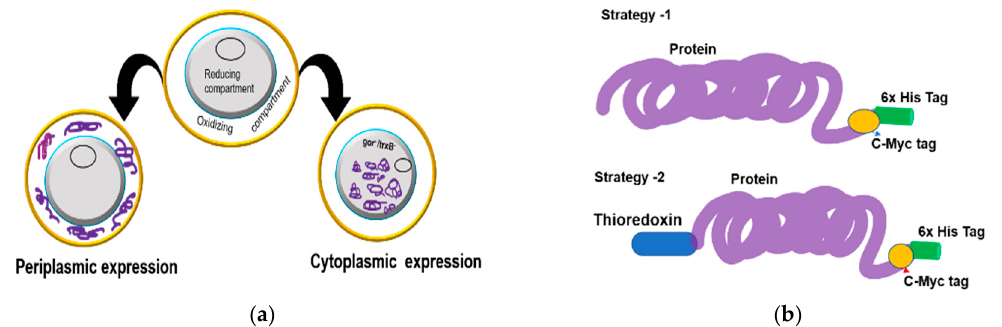
Figure 3. Schematic presentation of the antibody expression in the microbial system. ( a ) Depiction of highly conserved disulfide-bonded antibody fragment in the periplasmic and cytosolic compartments; ( b ) design of the antibody fragment with a thioredoxin tag as a chaperone protein for expression in an oxidative cytosolic environment. The 6xHis tag and c-Myc tag serve as an a ffi nity purification tag and a signal detection tag, respectively.